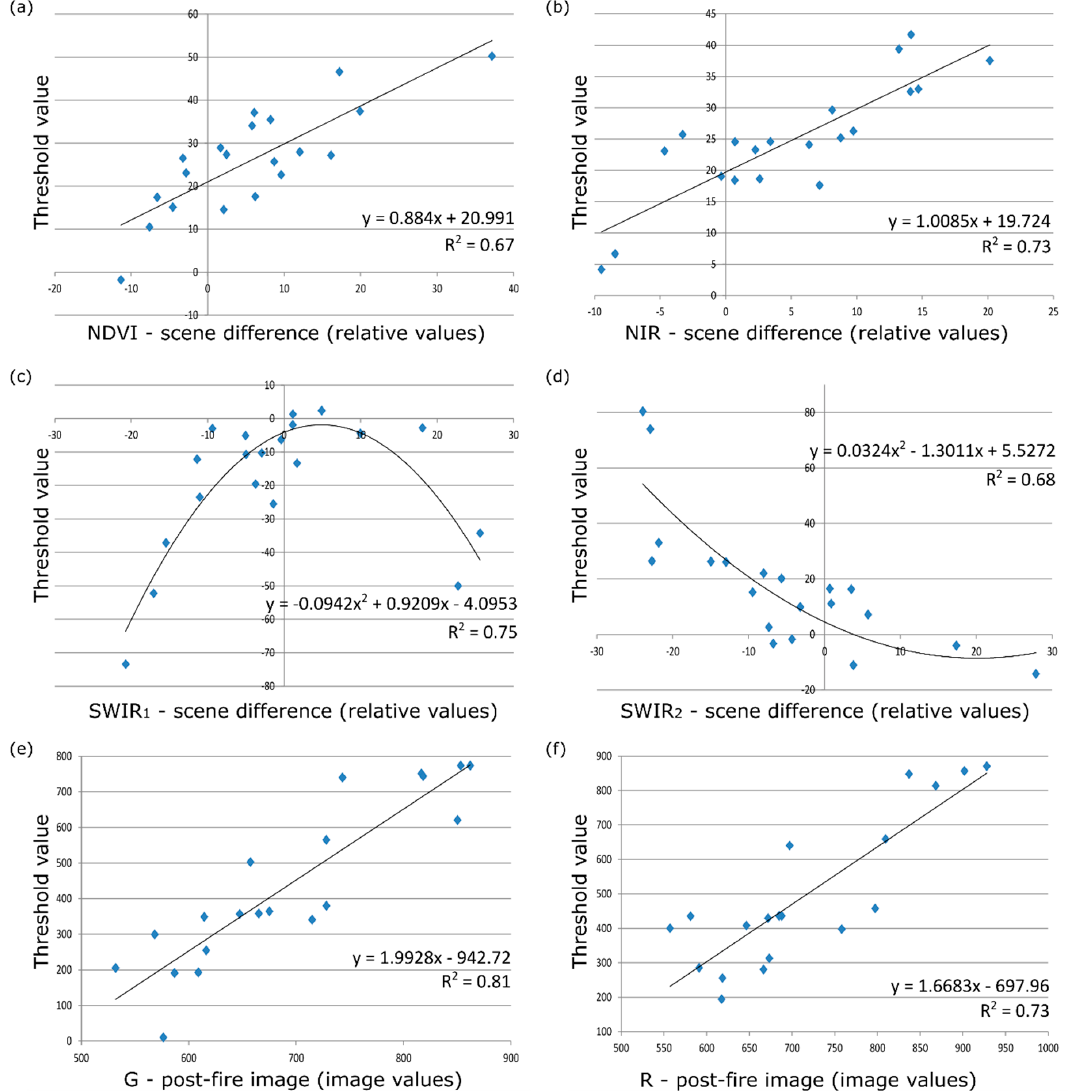
Figure 3. The function to calculate threshold values.